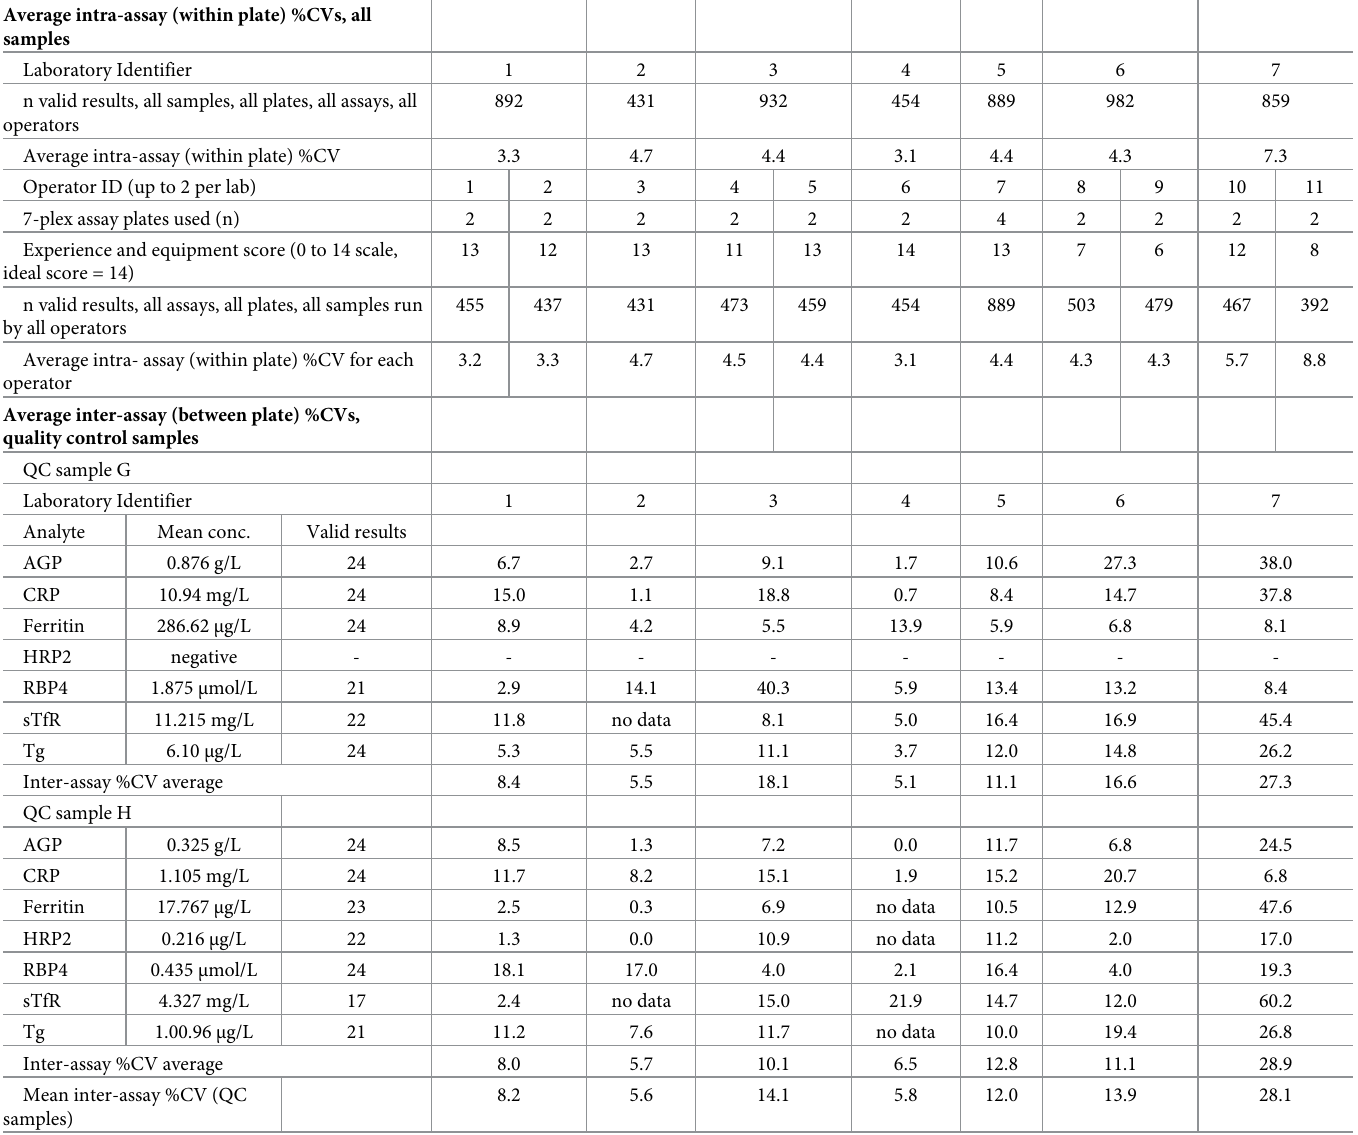
Table 2. Average intra-assay (within-plate) and inter-assay (between plate) %CVs by laboratory and operator. Average intra-assay (within plate) %CVs, all